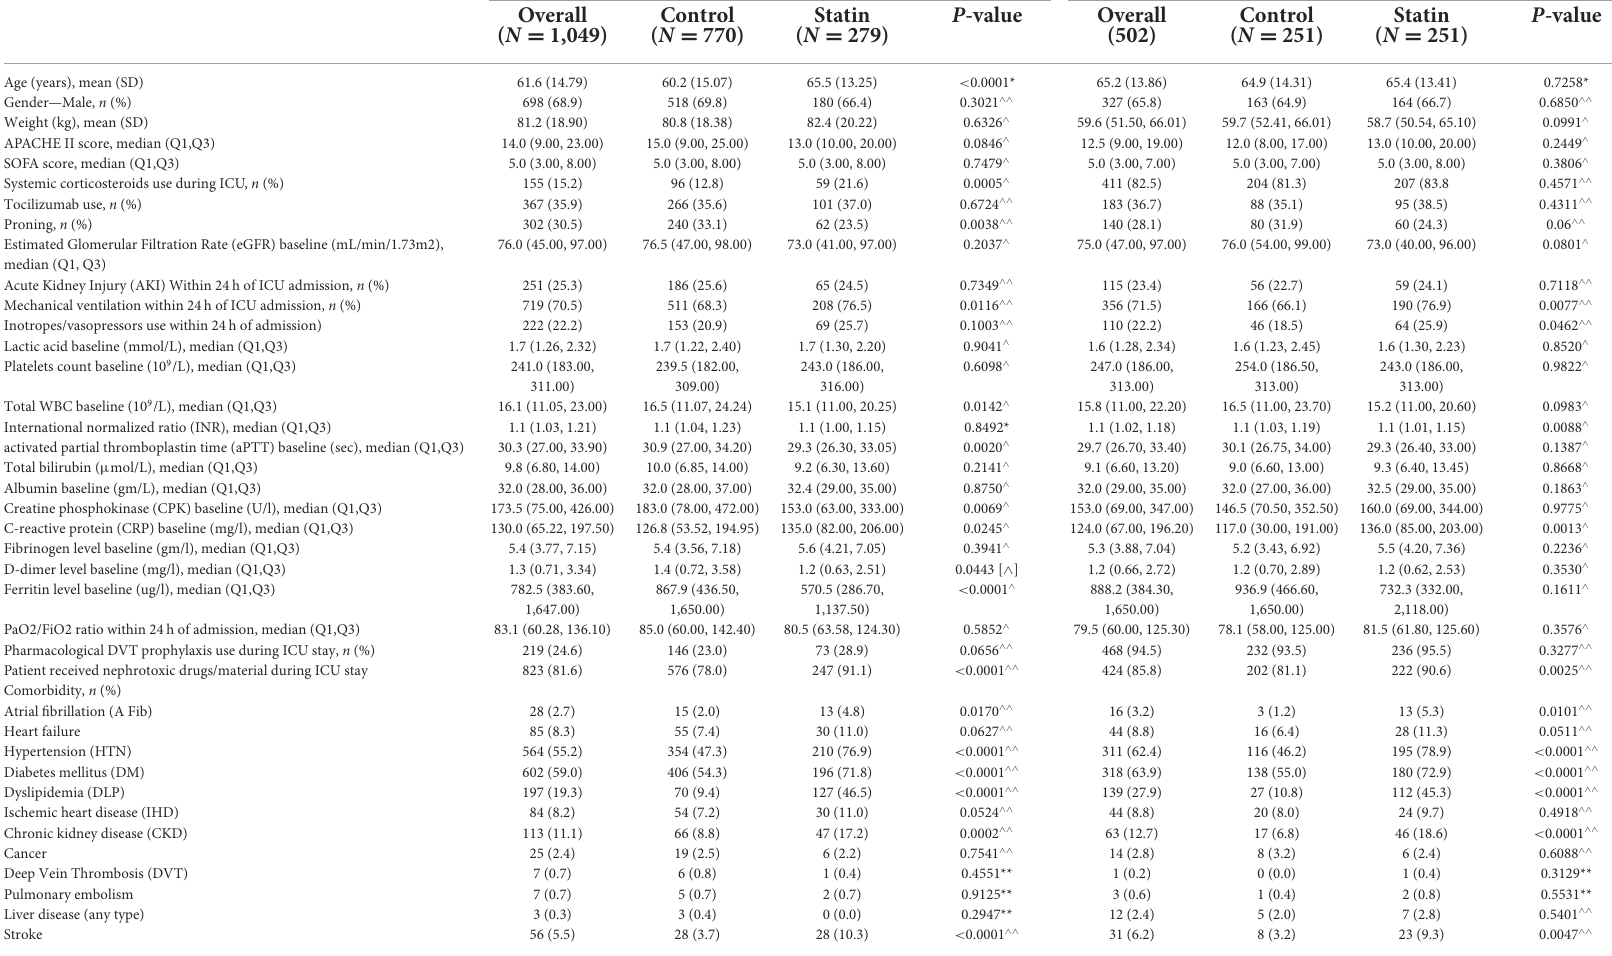
TABLE 1 Summary of demography and baseline characteristics. Before propensity score (PS) adjustment After propensity score (PS)